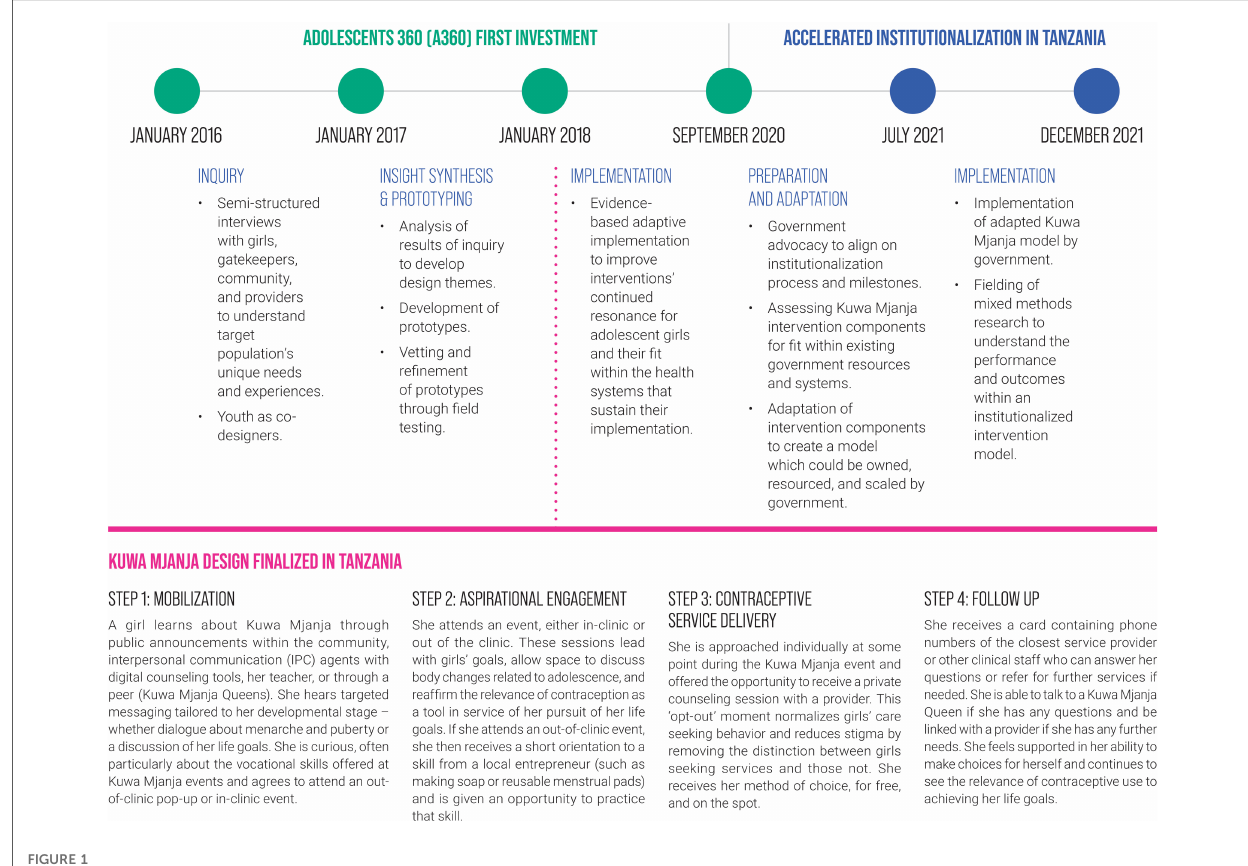
FIGURE 1 A360 Tanzania timeline and Kuwa Mjanja implementation